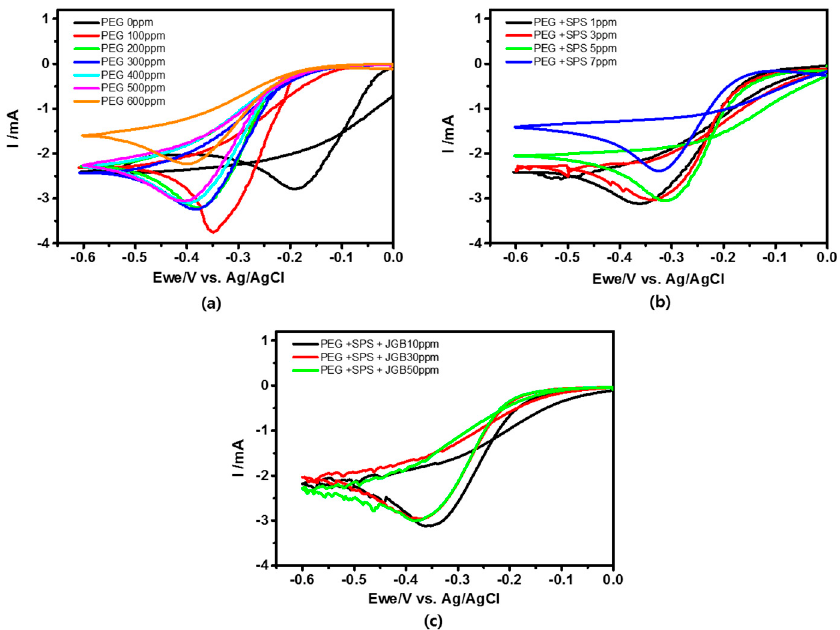
Figure 4. Result of cyclic voltammetry (CV): ( a ) CV curve according to the poly(ethylene glycol) (PEG) concentration in the virgin makeup solution (VMS) bath; ( b ) CV curve according to the bis-(3-sodiumsulfopropyl disulfide) (SPS) concentration in a VMS bath with 500 ppm PEG; ( c ) CV curve according to Janus Green B (JGB) concentration in a VMS bath with 500 ppm PEG and 3 ppm SPS.